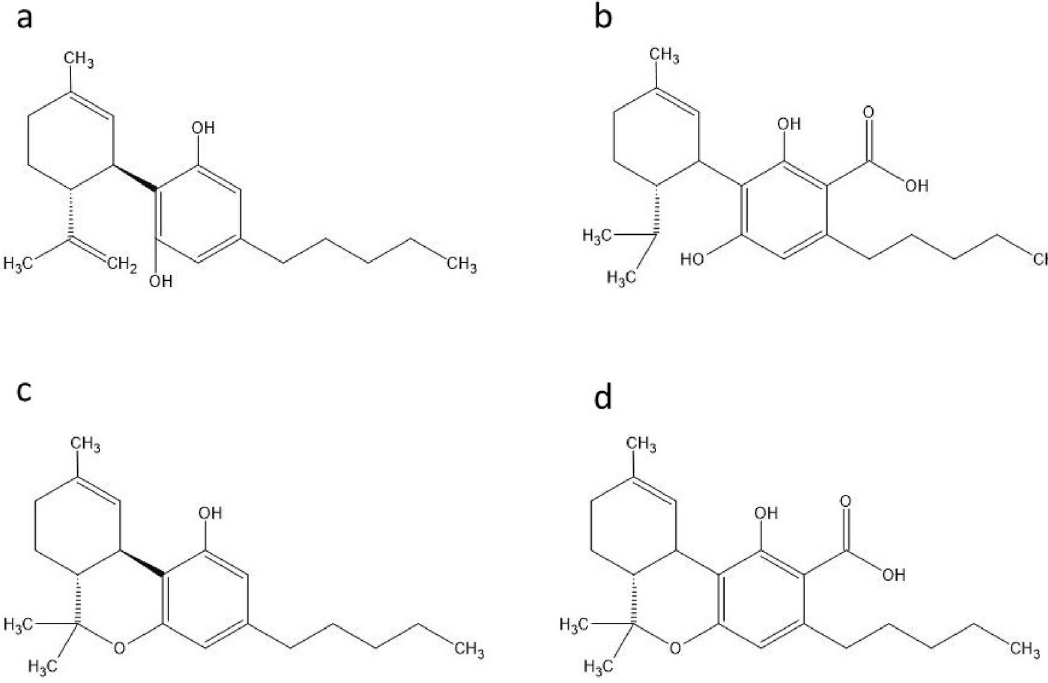
Figure 4. Molecular structures of cannabidiol ( a ), cannabidiol acid ( b ), tetrahydrocannabinol ( c ) and tetrahydrocannabinol acid ( d ). Source Thomas and ElSohly 53